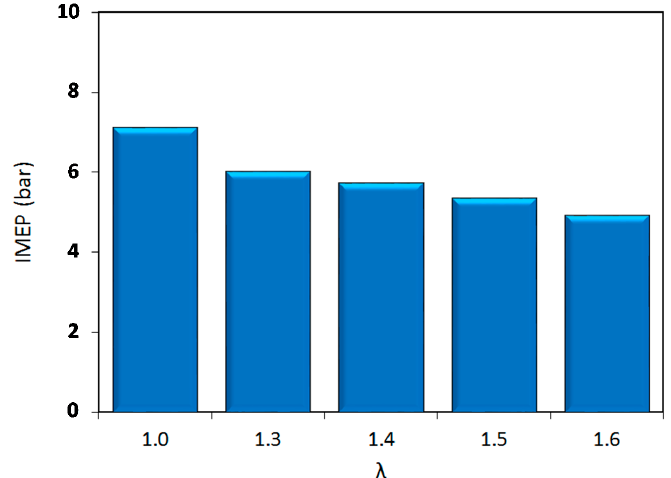
Figure 3. IMEP evaluated as average on 200 consecutive engine cycles for different air fuel ratios.